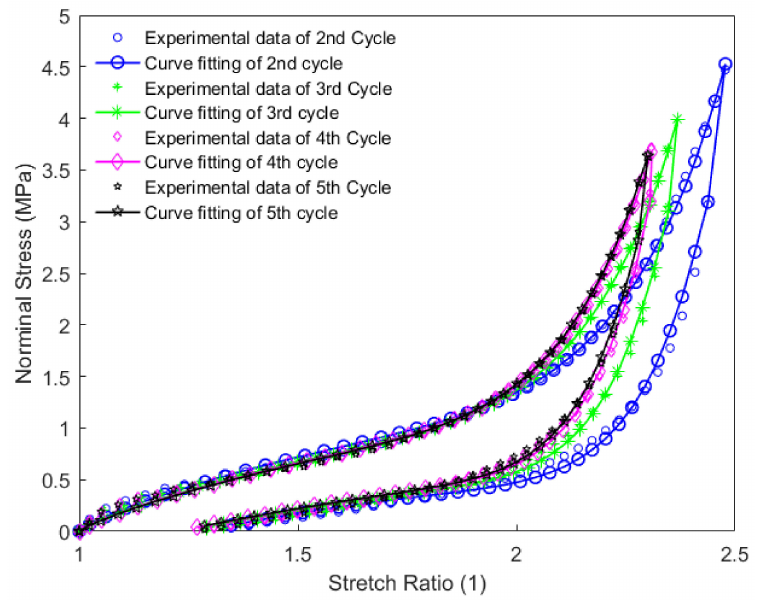
Figure 11. Model prediction of the second to the fifth cycle during the cyclic tension process of the high-damping rubber